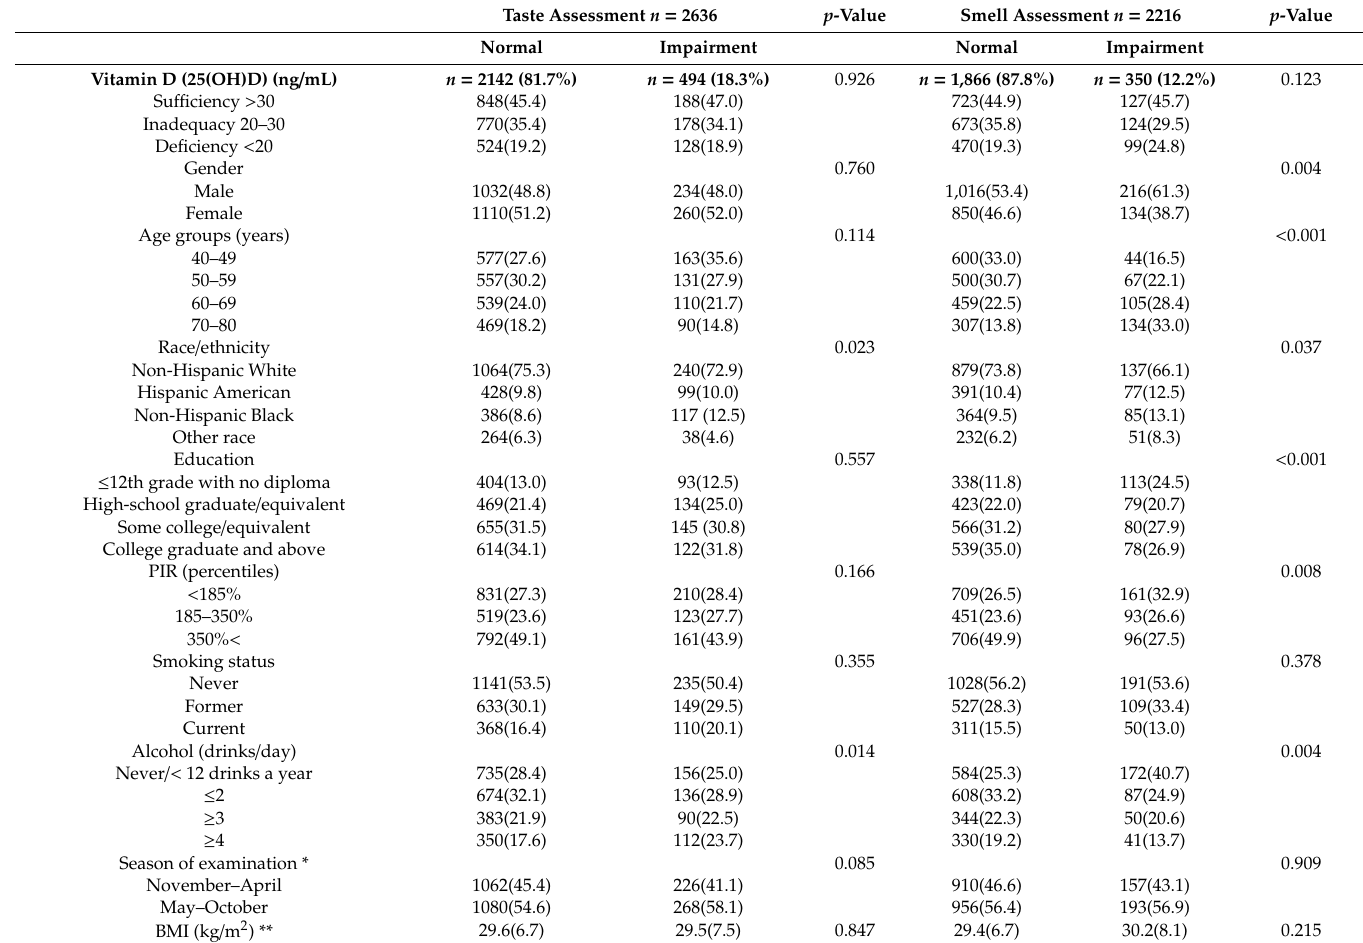
Table 1. Summary statistics of the study sample according to smell and taste assessments in American adults aged 40–80 years, the NHANES